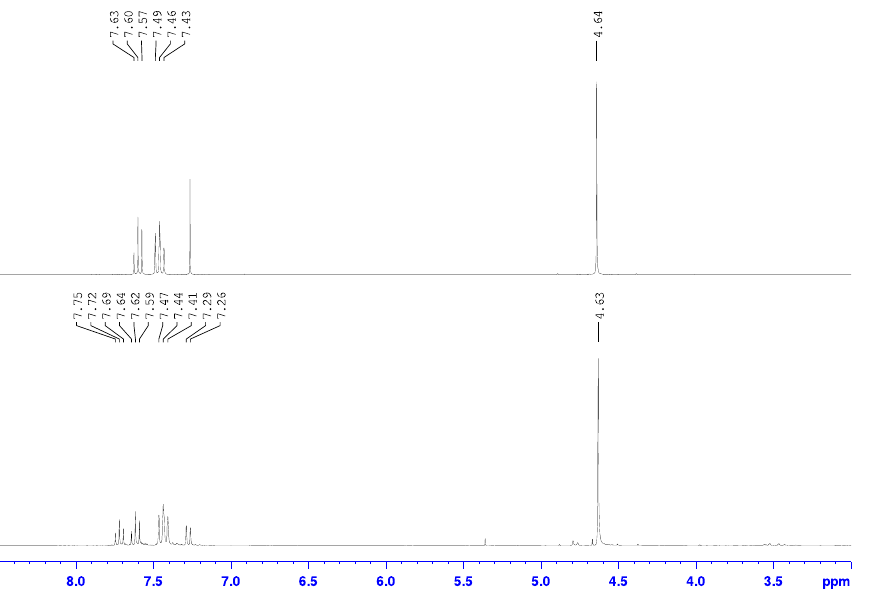
Figure 5. Overlay of the 1 H-NMR spectra for the product mixture from the reaction of 2-bromo-6- hydroxymethylpyridine with cyanuric chloride • DMF in DCM at r.t (top) and SOCl 2 at 40 ◦ C (bottom) in CDCl 3 .